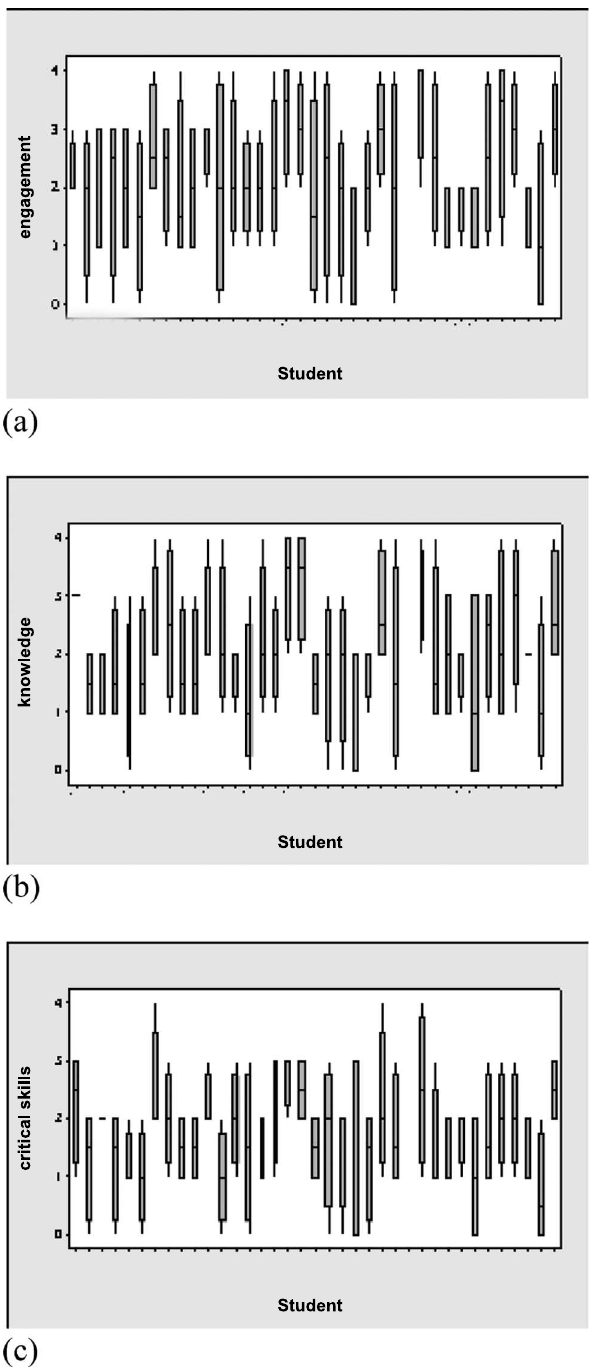
Figure 7. Boxplots of (a) engagement, (b) knowledge, (c) critical